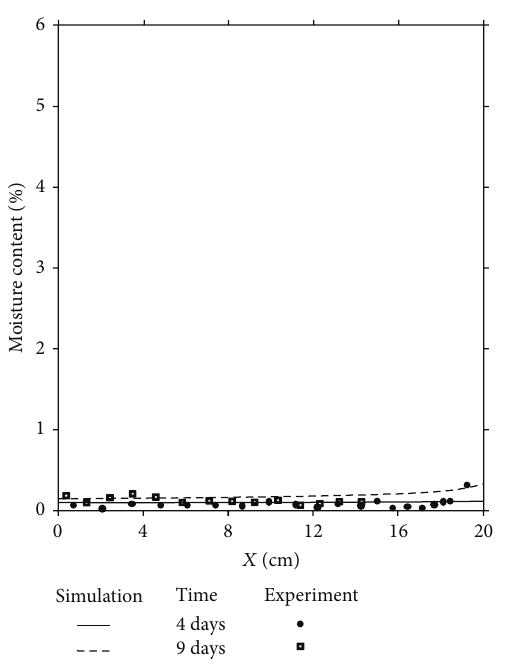
Figure 3: Moisture content distributions for 𝑡 = 4 days and 𝑡 = 9 days. Comparison between experiment and numerical simulation.